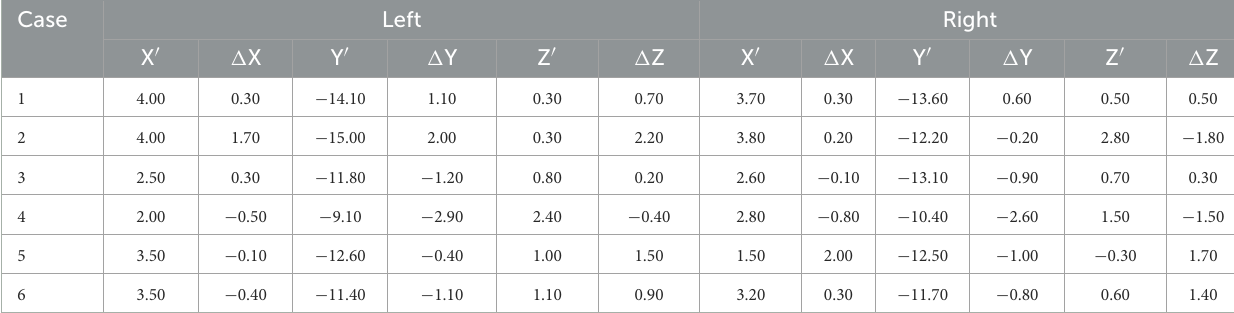
TABLE 3 Actual implantation coordinates of the DBS electrode tips (mm) and differences from the target.